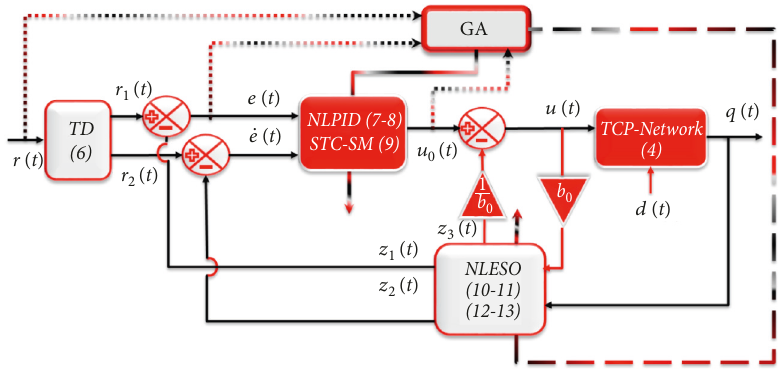
Figure 3: Completed diagram of the TCP/AQM based on the proposed